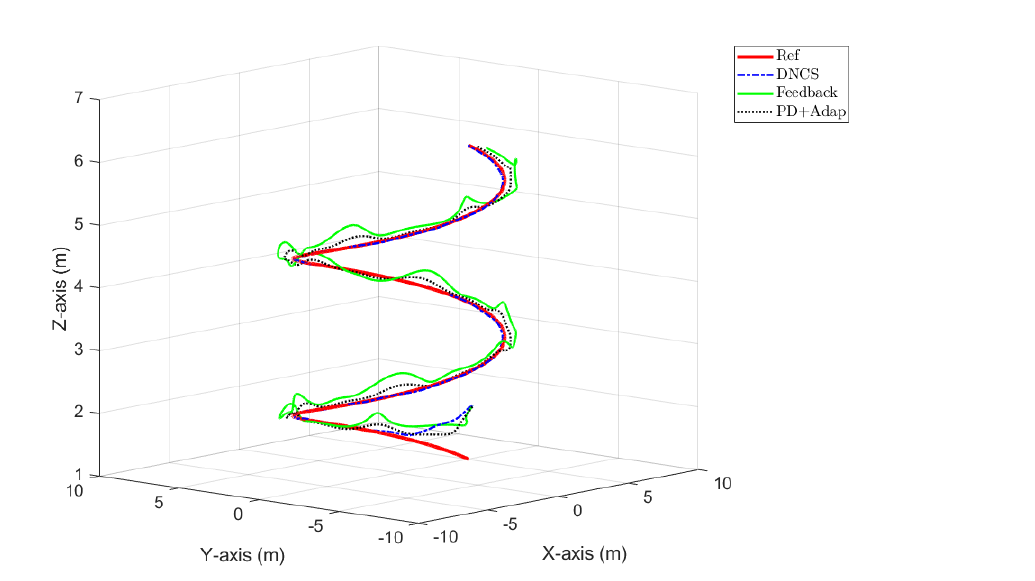
Figure 5. Underwater vehicle response in a 3D helical desired trajectory scenario by using the DNCS, Feedback and PD Adaptive